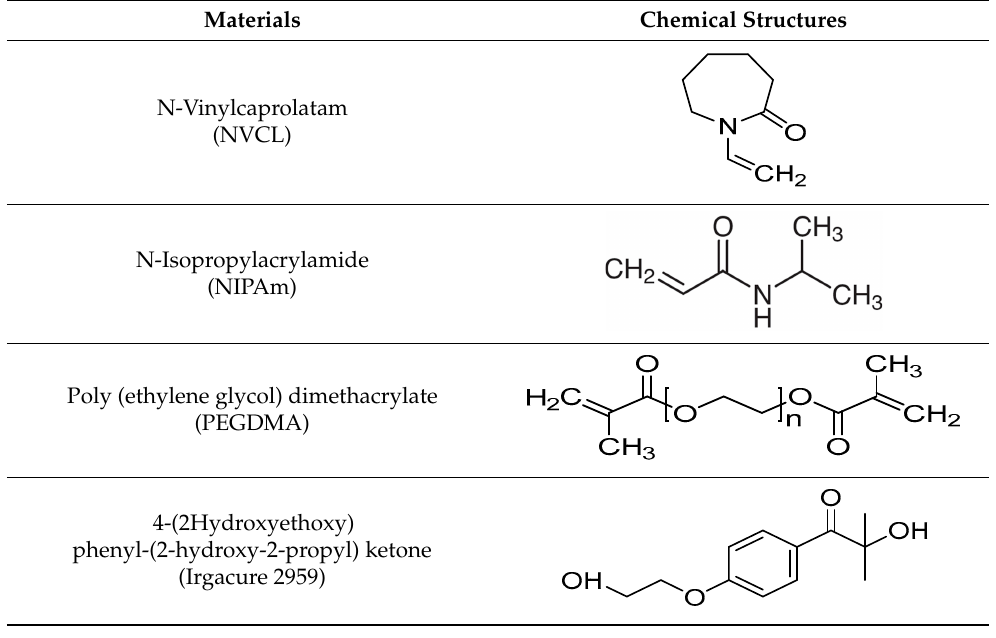
Table 3. Materials used and their chemical structure.